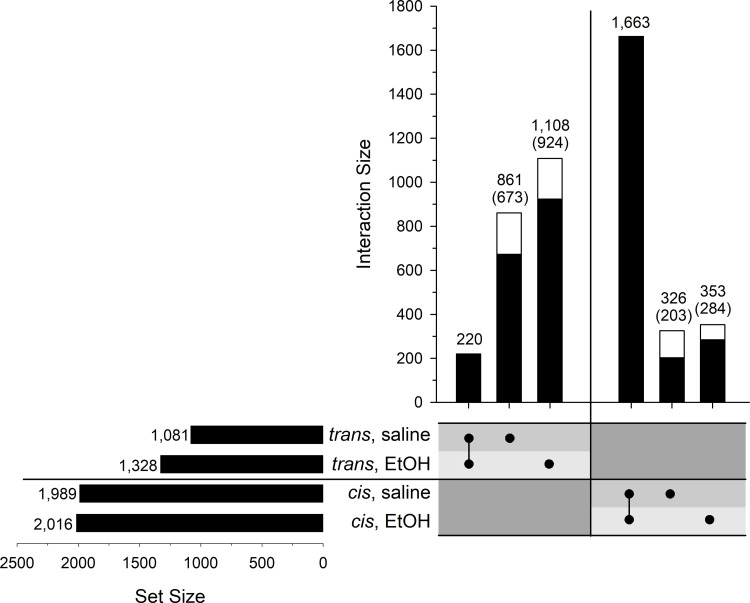
UpSet plot of the number of eQTLs in the LXS RI panel following saline or ethanol (EtOH) pretreatment.Set Size is the total number of eQTLs in each group. Interaction Size represents the number of eQTLs in the intersections of the groups as indicated by the black dots below the bars. The black portion of the bars in the Interaction panel represents the number of pretreatment-unique eQTLs that are “golden” (see text). The number of those “golden” eQTLs is shown in parentheses.